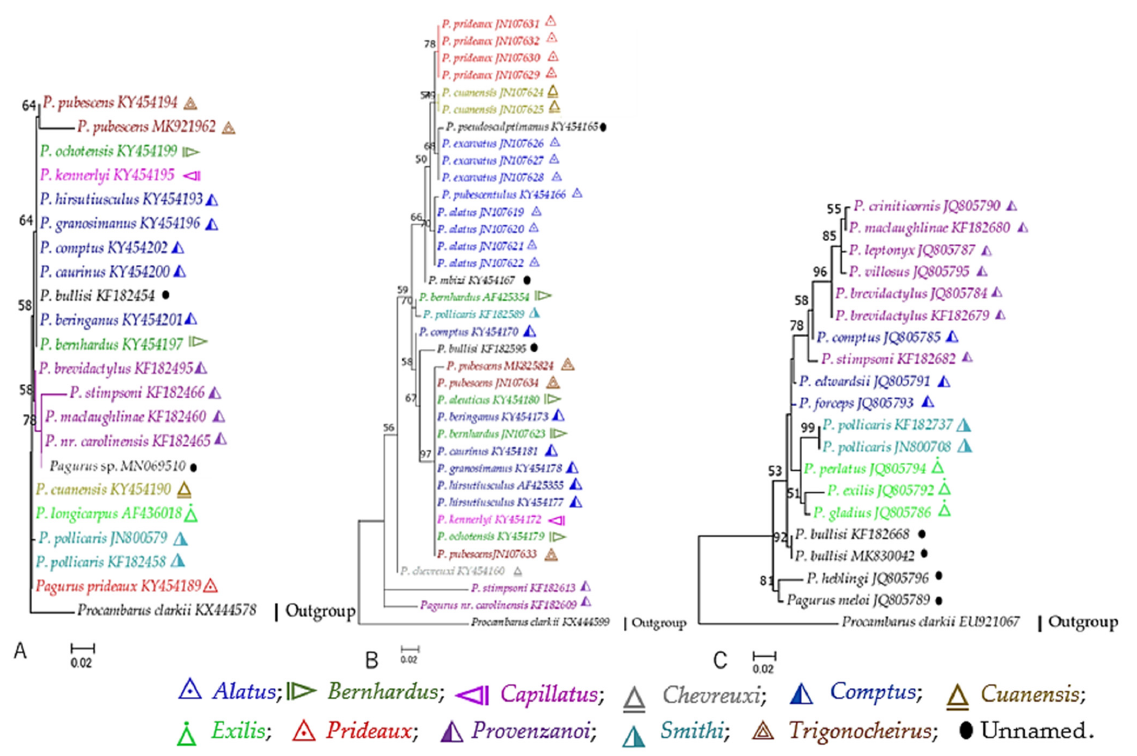
Figure 6. Individual gene trees based on maximum-likelihood (ML) method with 1000 bootstraps constructed from nuclear markers of Pagurus species: ( A ) (18S), ( B ) (28S), and ( C ) (H3). Numbers at nodes represent bootstrap value in percentages; value below 50% are not shown. The species name and sequence accession number are shown for each sample. Different colors represent the morpho-based species groups.